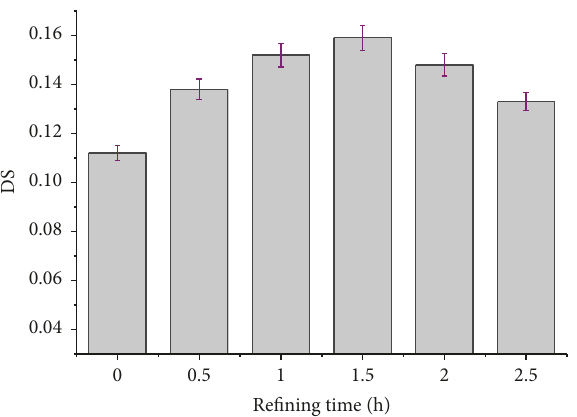
Figure 3: Effect of refining time on DS of cellulose.